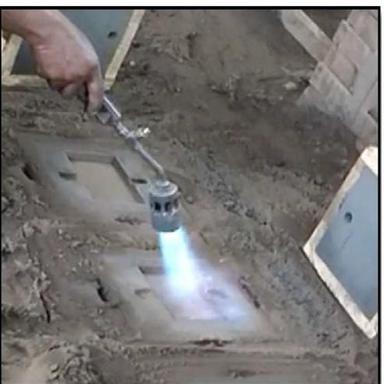
Mould Firing Process.